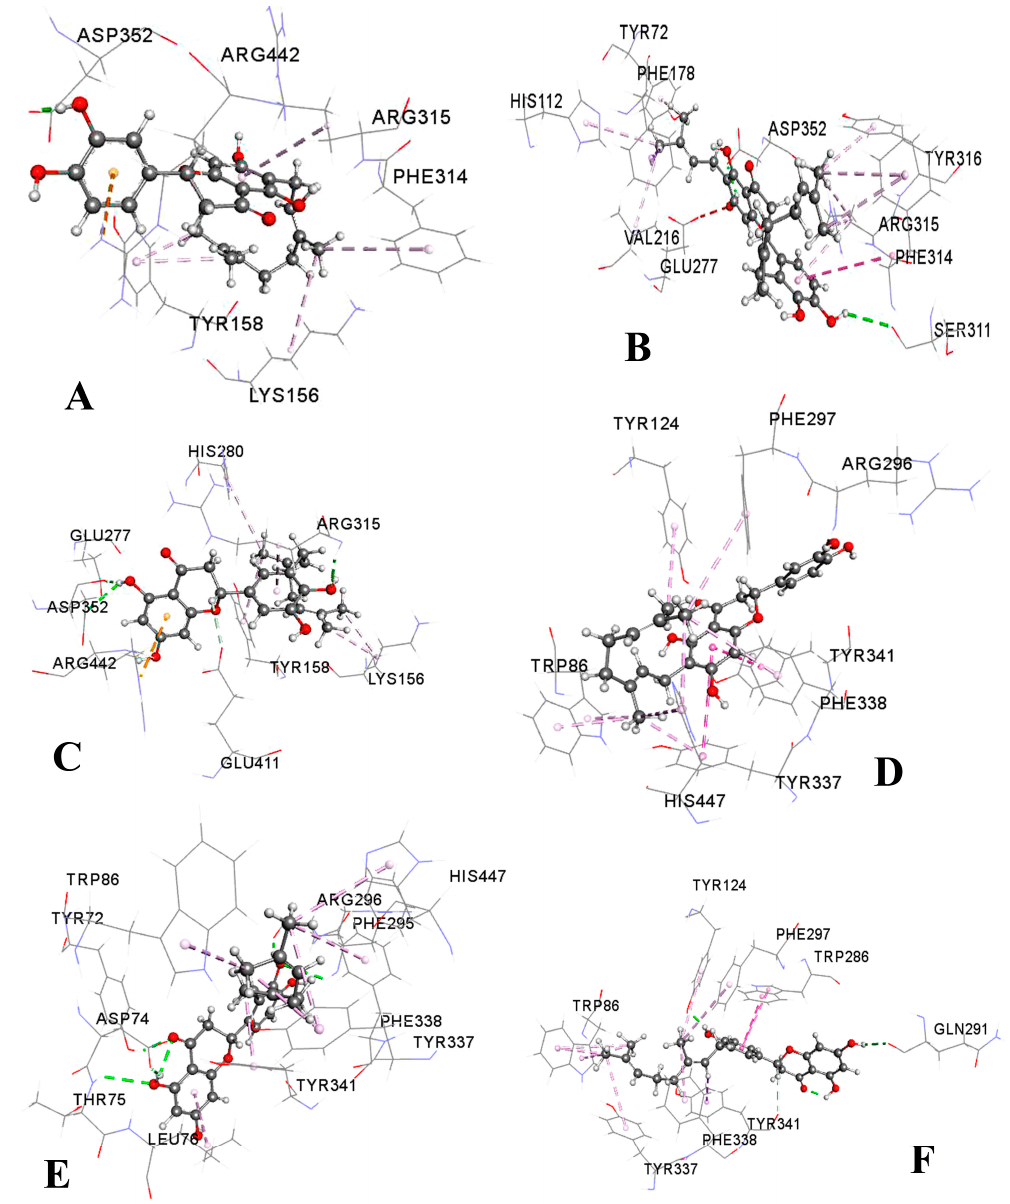
Figure 6. Non-bonded interactions of the best-docked compounds with α -glucosidase (Protein Data Bank identifier (PDB ID): 3A4A) and acetylcholinesterase (PDB ID: 4EY7) proteins. ( A ) Nymphaeol-A (NA) with 3A4A, ( B ) nymphaeol-C (NC) with 3A4A, ( C ) isonymphaeol-B (INB) with 3A4A, ( D ) NA with 4EY7, ( E ) nymphaeol-B (NB) with 4EY7, and ( F ) 3 ′ -geranyl-naringenin (GN) with 4EY7.